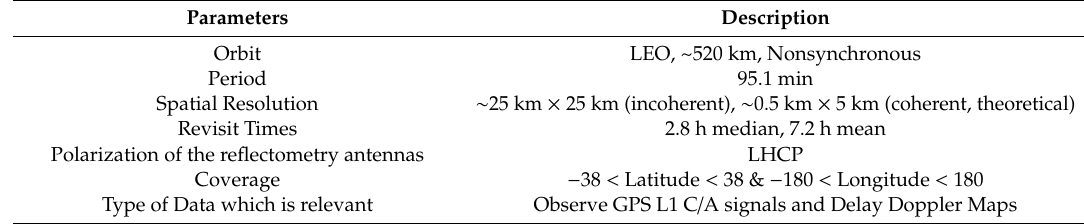
Table 1. The Cyclone Global Navigation Satellite System (CYGNSS) satellite